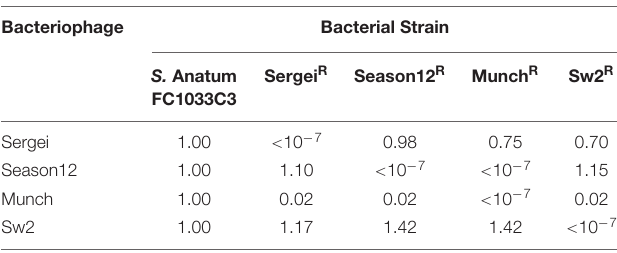
TABLE 2 | Phage efficiencies of plating (EOP) on the parental strain S. Anatum FC1033C3 and its four phage-insensitive derivatives. Bacteriophage Bacterial Strain